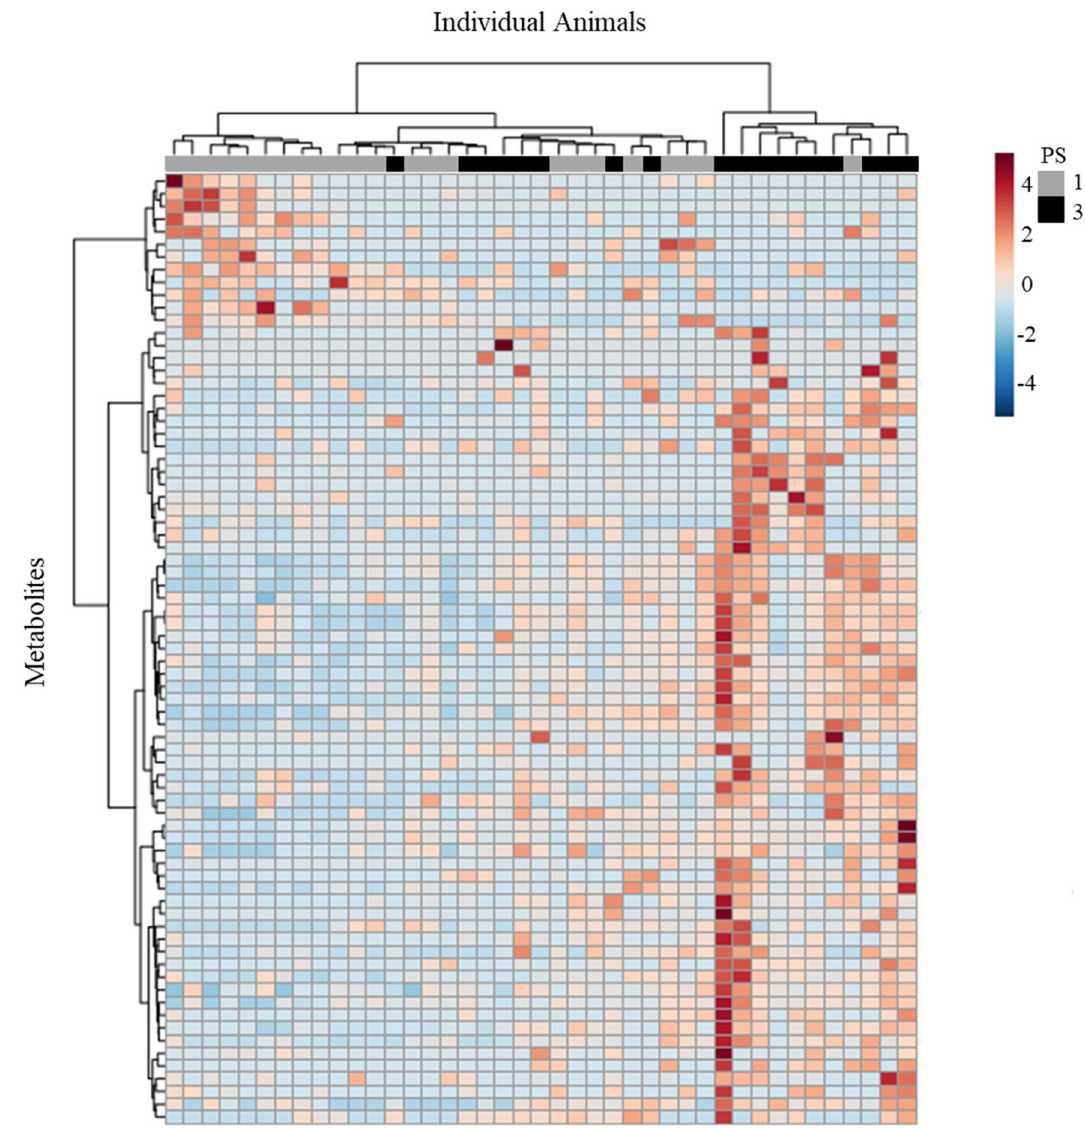
Figure 6. Differences in serum metabolites between PS1 and PS3 sows. This heat map displaying the 75 molecular features with the highest statistical significance (lowest p-values), illustrates relative abundance of serum metabolites (represented by color) between low POP risk (PS1) and high POP risk (PS3) sows. PS3 scored sows (black) cluster to the left of the dendrogram separate from PS1 scored sows